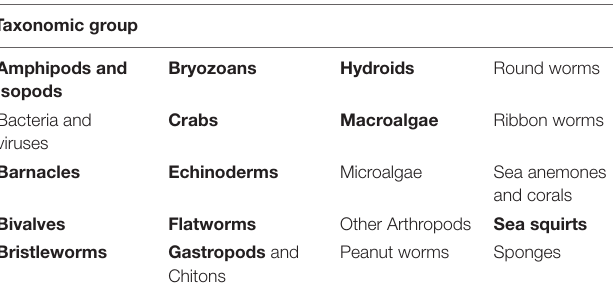
Amphipods and Hydroids Round worms isopods Macroalgae Ribbon worms Echinoderms